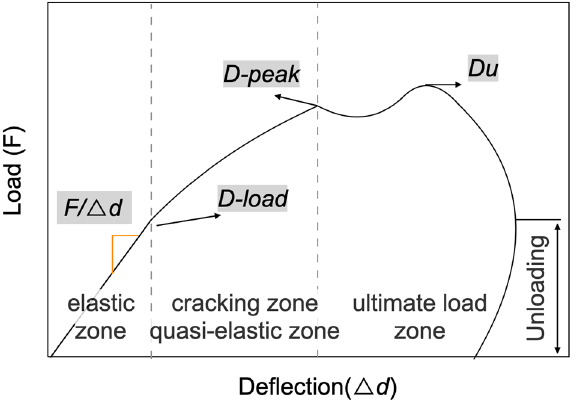
8 of 21 Figure 6. Schematic of the laser displacement measurement installation position. 2.4. Bearing Capacity Characterization 2.4.1. D ‐ Load, Peak Load and Ultimate Load The D ‐ load is the design load of a pipe obtained from a three ‐ edge bearing test (TEBT), defined as the load corresponding to a 0.01 ‐ inch (0.3 mm) crack [28]. Peak load is defined as the load corresponding to the end of the linear relationship between the load and deformation of pipe, which occurs slightly before the ultimate load, and is denoted as D ‐ peak [32]. The ultimate load, also referred to as D u , is defined as the maximum load